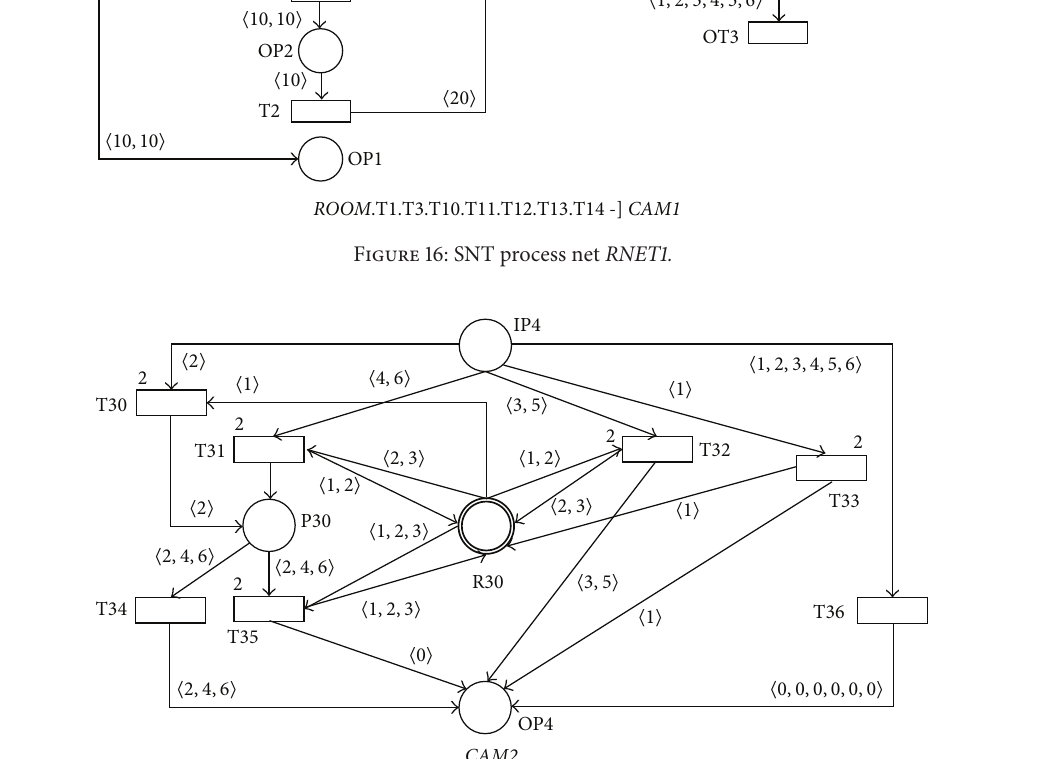
Figure 17: SNT process net